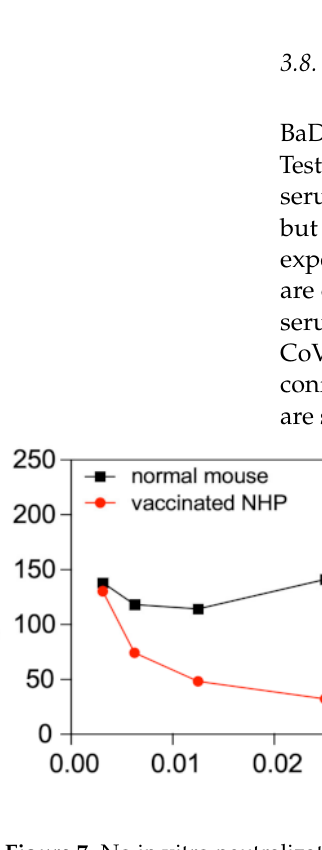
Figure 7. No in vitro neutralization of SARS-CoV-2 by immunized mouse sera. Focus reduction neutralization tests were performed with sera from mice immunized with controls and vaccine candidates. The left panel shows assay controls: the negative control (normal mouse serum) has 125–150 foci per well at all serum dilutions, while incubation with the positive control (vaccinated non-human primate serum) reduces the number of foci per well. No reduction in foci was observed after incubation with any of the experimental sera, including that from mice immunized with Spike + LPS (right panel). This lack of neutralization likely results from unproductive conformations of the Spike protein and displayed